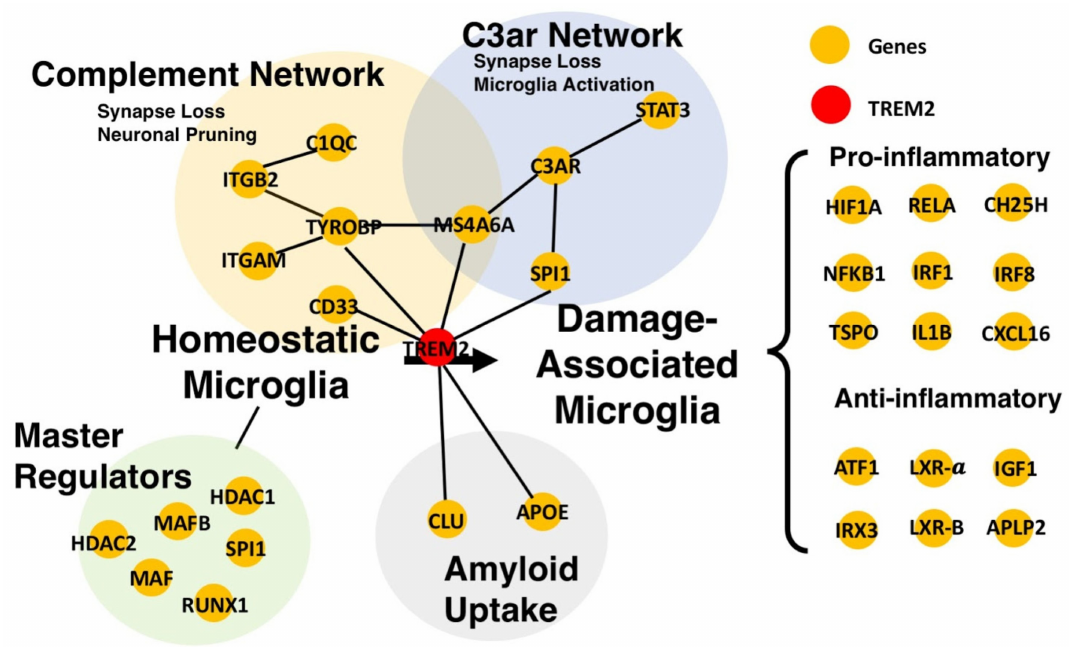
Figure 2. Network representation of Triggering Receptor Expressed on Myeloid Cells 2 (TREM2) and its interacting partners in the context of the switch from homeostatic microglia to damage-associated microglia (DAM). Only representative genes are shown in the network. Hence, the genes included in this TREM2-network are neither comprehensive nor exhaustive of the processes, transcriptional networks or signature they belong to. However, several transcriptional gene network studies demonstrated the role of TREM2 at the center of a complex interplay between cellular processes (e.g., synapse loss and neuronal pruning) and multifold genetic and epigenetic regulators, which account for the dynamic nature and functions of microglia in AD. Representative genes shown are taken from Rangaraju et al. (2018) [62] , Litvinchuk et al. (2018) [112] , Keren-Shaul et al. (2017) [133], Matcovitch-Natan et al. (2016) [136], and Zhang et al. (2013)